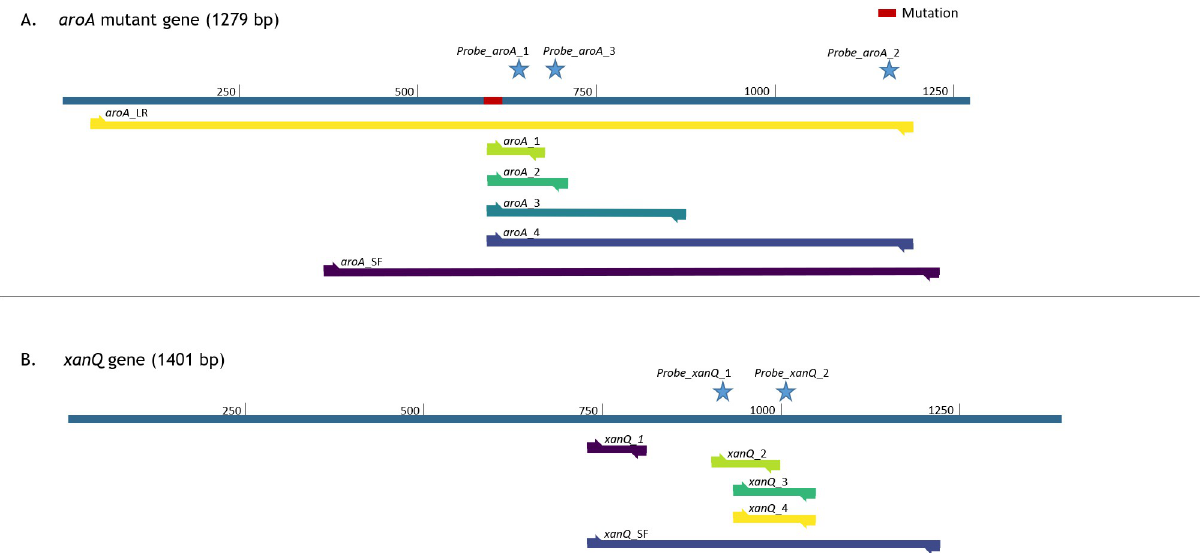
Fig 1. Graphical representation of the primers and probes used in this study. (A) The aroA mutant gene (1279 bp) is schematically represented by the blue line on which the mutation is indicated in red. Underneath this line, the amplicons generated by the different primer pairs (arrows) are represented. Above the schematic gene representation, the location of the probes is indicated with a star. Since this figure depicts the aroA mutant gene, the primer pair aroA _WT cannot be represented. (B) A similar representation for the xanQ gene (1401 bp) in blue with probes (above) and primers